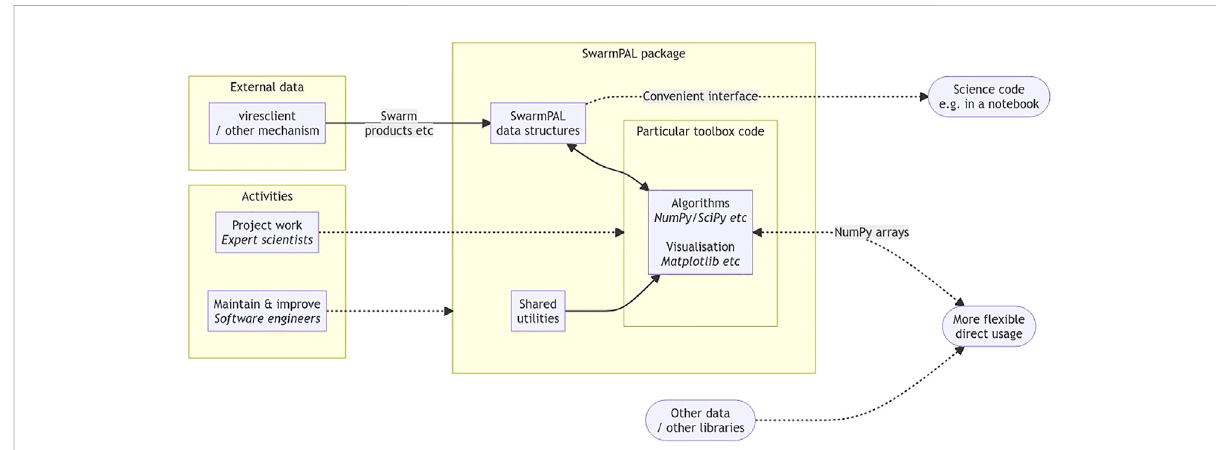
FIGURE 5 Schematicforthestructureandusagepatternsfor SwarmPAL .WhilethepackageprovidesinterfacestoruncodeimmediatelywithSwarmdata, hiding away the data access and processing steps, the underlying routines are accessible to use in more fl exible ways through standard objects like NumPy